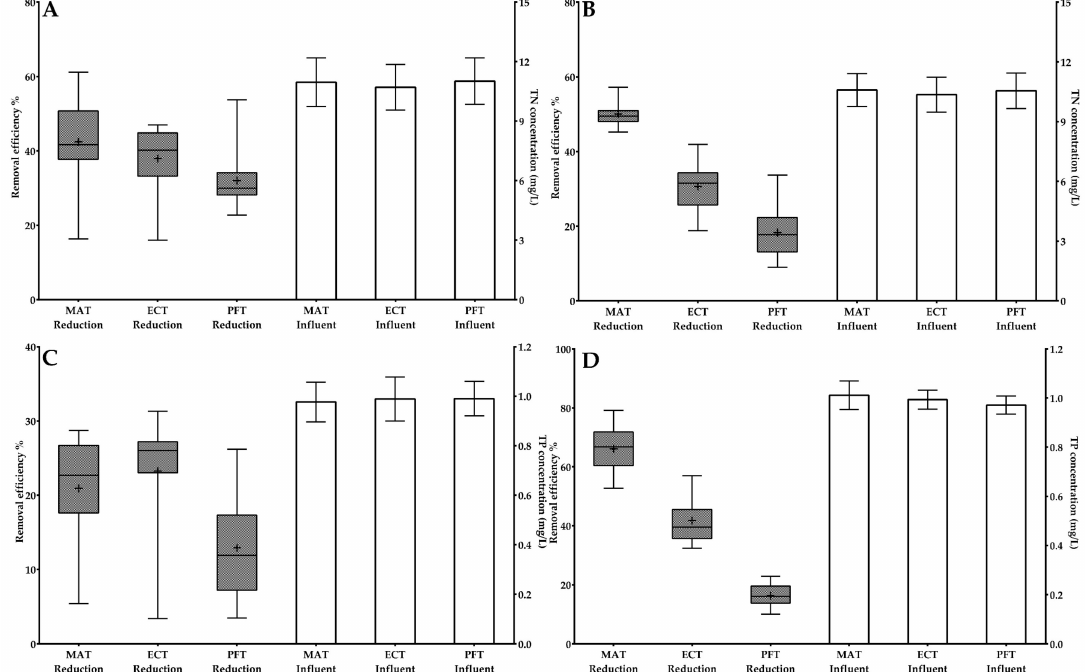
Figure 4. Removal efficiencies and influents of total nitrogen (TN) and total phosphorus (TP) in the LSCW at different HRTs. TN influents and removal efficiencies for different treatments are shown at HRTs of 4 d ( A ) and 7 d ( B ), whilst TP influents and removal efficiencies are shown at 4 d ( C ) and 7 d ( D ). MAT, ECT, and PFT represent LSCW treatment with M . aquaticum , E . crassipes , and polyethylene fiber, respectively. Black solid lines and plus signs represent the median and mean of the datasets, respectively. The bottom and top edges of box plots indicate the 25th and 75th percentiles, and the whiskers illustrate the 2.5th and 97.5th percentiles. The bar plots stand for the means of influent pollutant concentrations, and error bars for the standard deviation